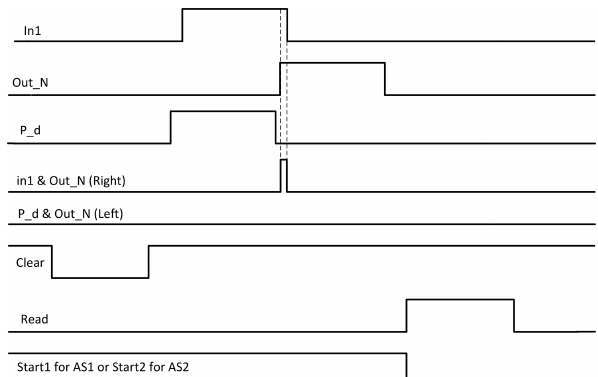
Figure 10. The timing chart of adaptation synapse. There are two pulses that check the time of the neuron fire before and after the rising edge of the neuron pulse, i.e., P_d pulse and in1 pulse, re- spectively. If the neuron fires at a specific time, the right and left signals are 1 and 0. The Read signal is used to read after a specific